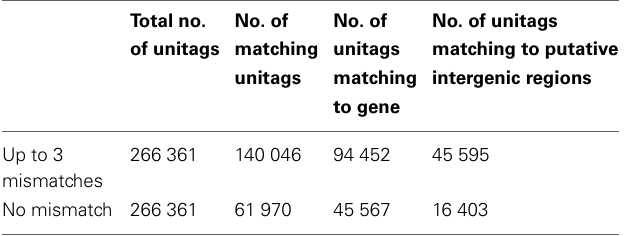
Table 3 | Summary of tags matching to the potato genome sequence. Total no.